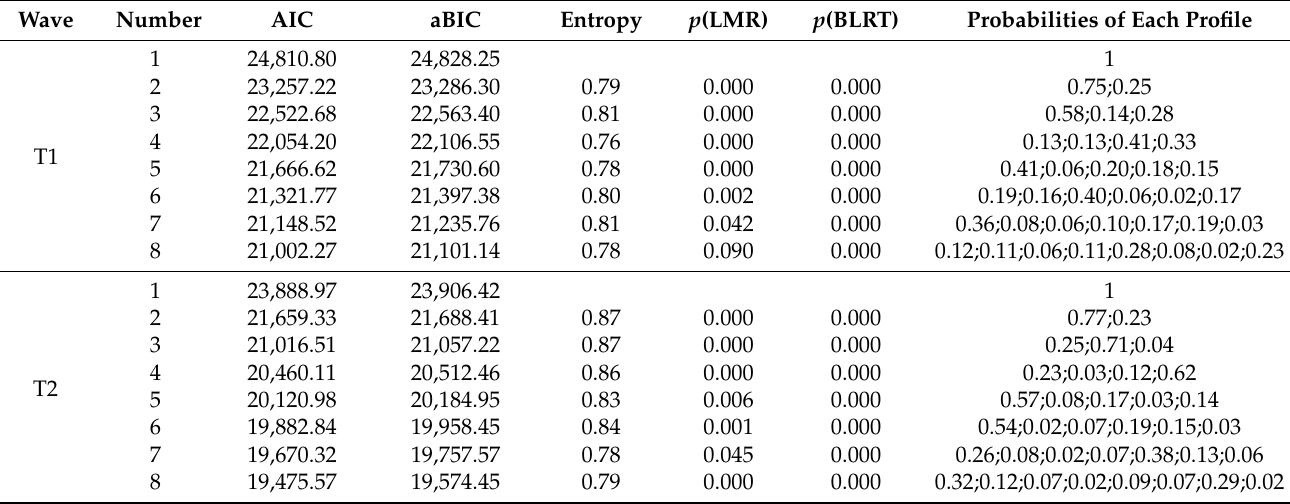
Table 1. Fit statistics for latent profiles of teacher burnout at T1 and